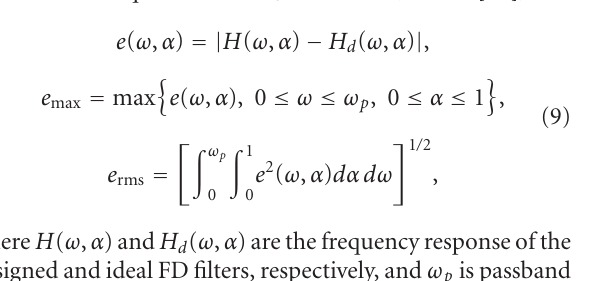
Figure 7: All band magnitude responses for (a) proposed method and (b) direct all band optimization.